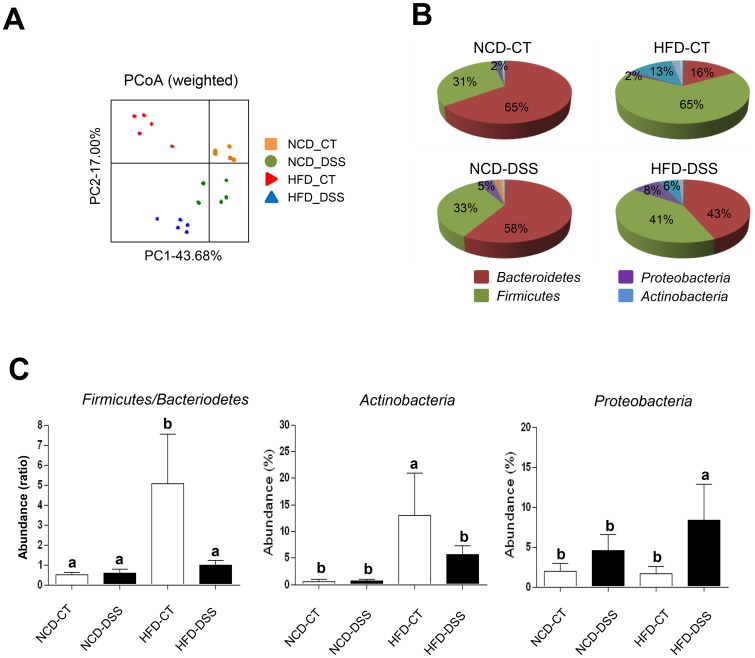
Alteration of intestinal microbiota following high-fat diet (HFD) feeding and dextran sodium sulfate (DSS) treatment.(A) Weighted principal coordinates analysis (PCoA) plots. Each spot represents one sample, and each group of mice is denoted by a different color. (B and C) Phylum-level changes of gut microbiota following HFD feeding and DSS treatment. Pie charts showing the differences in the relative abundances (%) of bacterial phyla (B). Changes of specific phyla (C). Normal chow diet (NCD)-control (CT), NCD-fed mice without DSS treatment; NCD-DSS, NCD-fed mice with DSS treatment; HFD-CT, HFD-fed mice without DSS treatment; HFD-DSS, HFD-fed mice with DSS treatment (n = 5 each). A one-way ANOVA was used to compare values among multiple groups. If an ANOVA test showed significant differences, the Duncan post-hoc test was used to compare two specific groups. If the Duncan test did not show a significant difference (P > 0.05), the two groups were labeled with the same letter over the respective bars. P values < 0.05 were considered statistically significant.